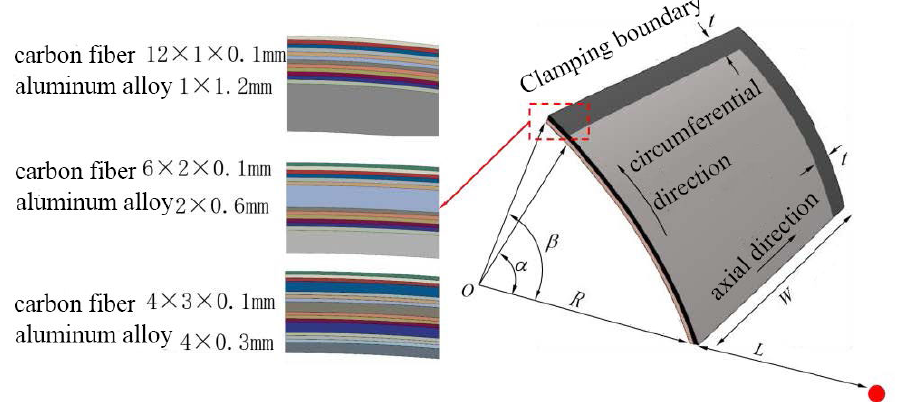
Figure 1. Schematic diagram of the CARALL simulation model.